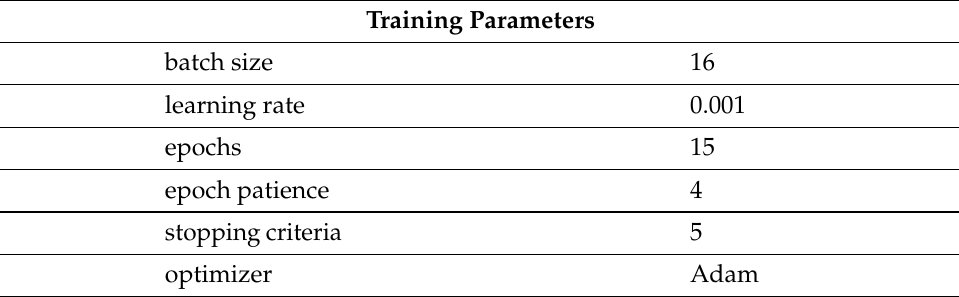
Table 2. Details of training parameters used for